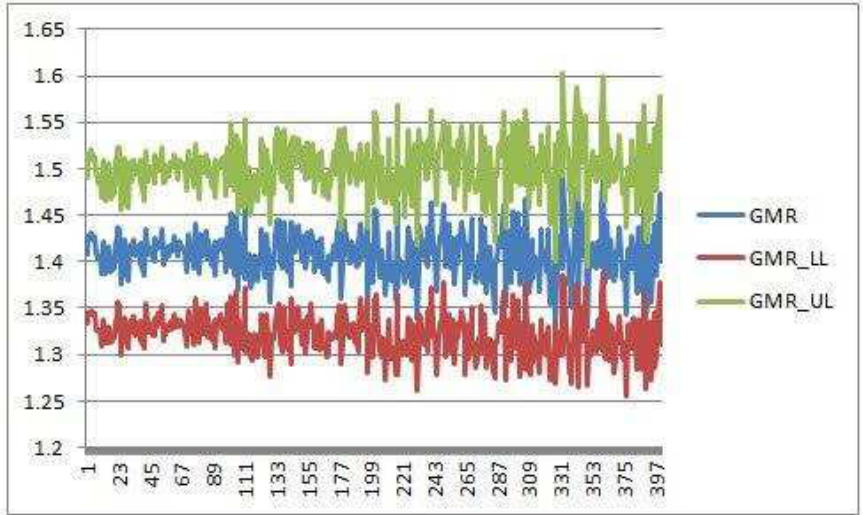
Figure 2 – Graphical represenation of GMR, LL and UL The GMR, LL and UL are above the BE acceptable limits, that is >